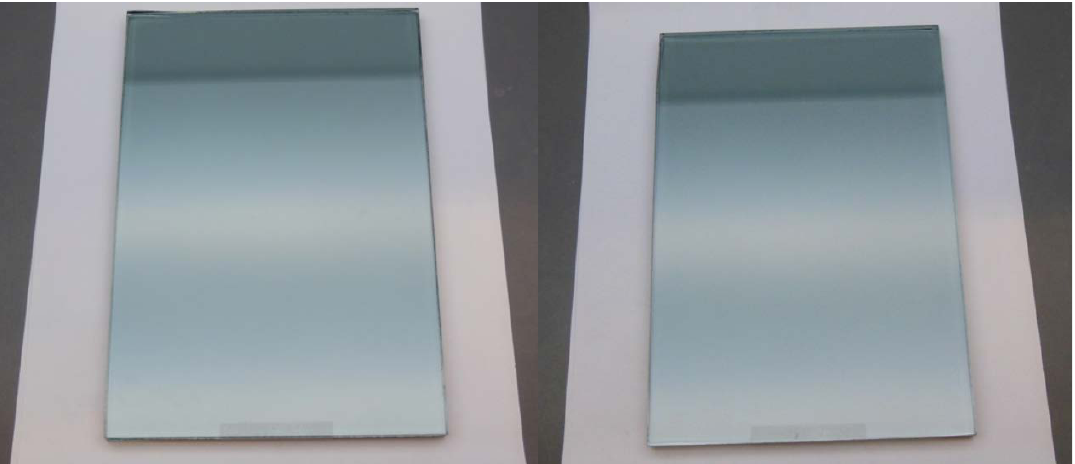
Fig. 4. Photograph of coating E, in position #2 (left side) and position #4 (right side) (illuminant D65 on white paper)